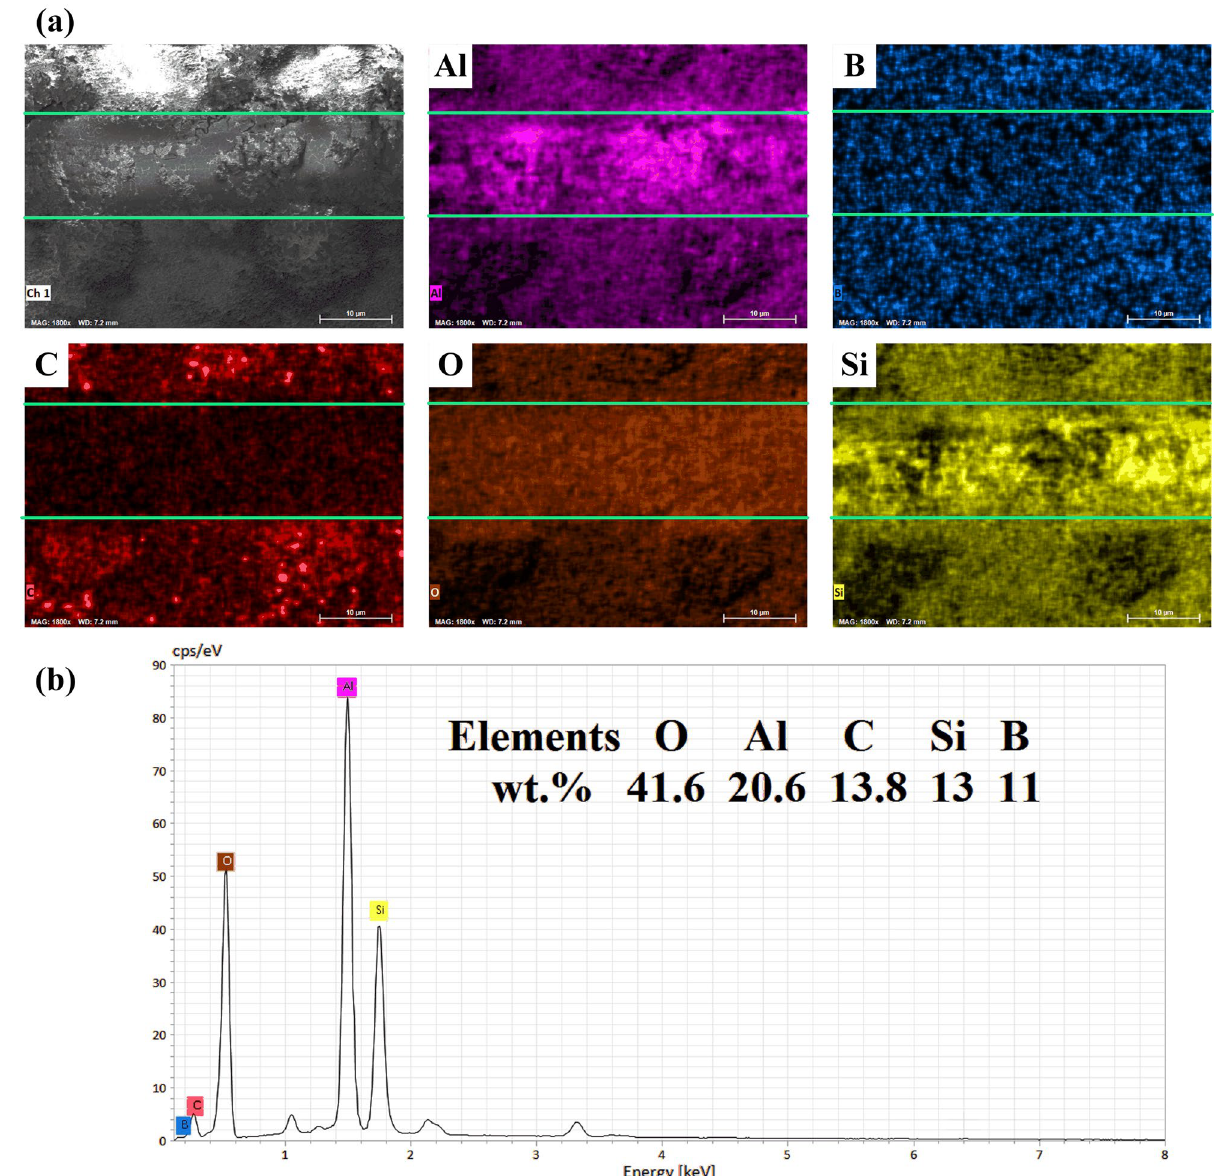
Figure 9. EDS of the wear scars. Subfigure ( a ) and ( b ) are the EDS of the wear scar surfaces of the coatings with h-BN particles that have been oxidized for 30 min,